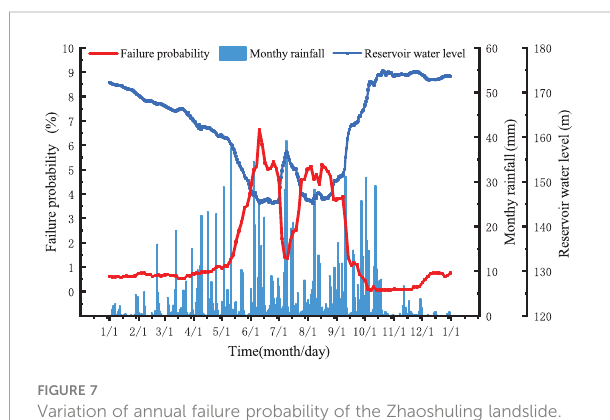
FIGURE 6 Convergence of safety of factor.